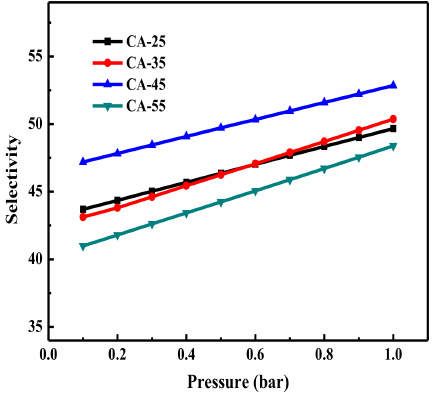
Figure 7. IAST selectivity of CO 2 /N 2 (15%/85% in volume) on the CA-X samples at 0 ◦